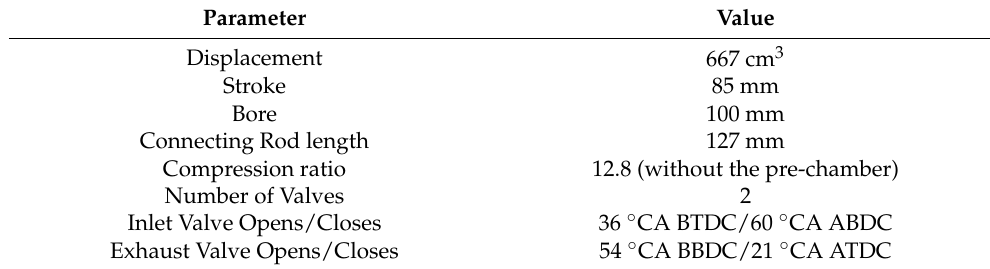
Table 3. Hatz 1D81Z engine technical data.